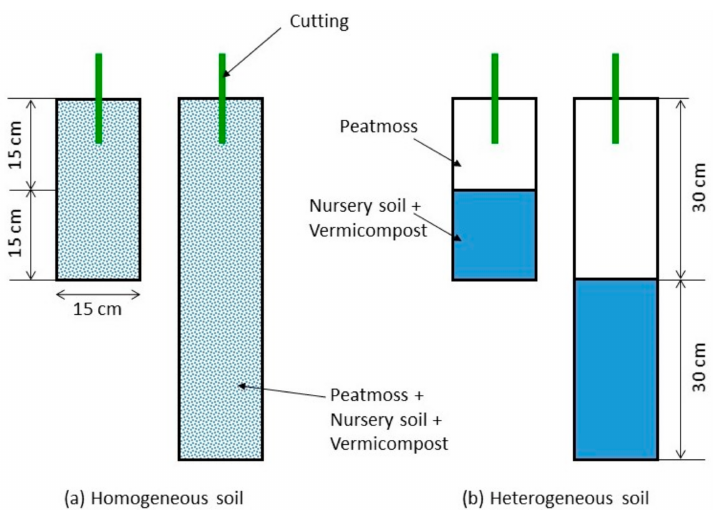
Figure 1. Layout of the experimental design showing the different container depth and substrate heterogeneity treatments: 30 and 60 cm container lengths with ( a ) homogenous and ( b ) heteroge- neous